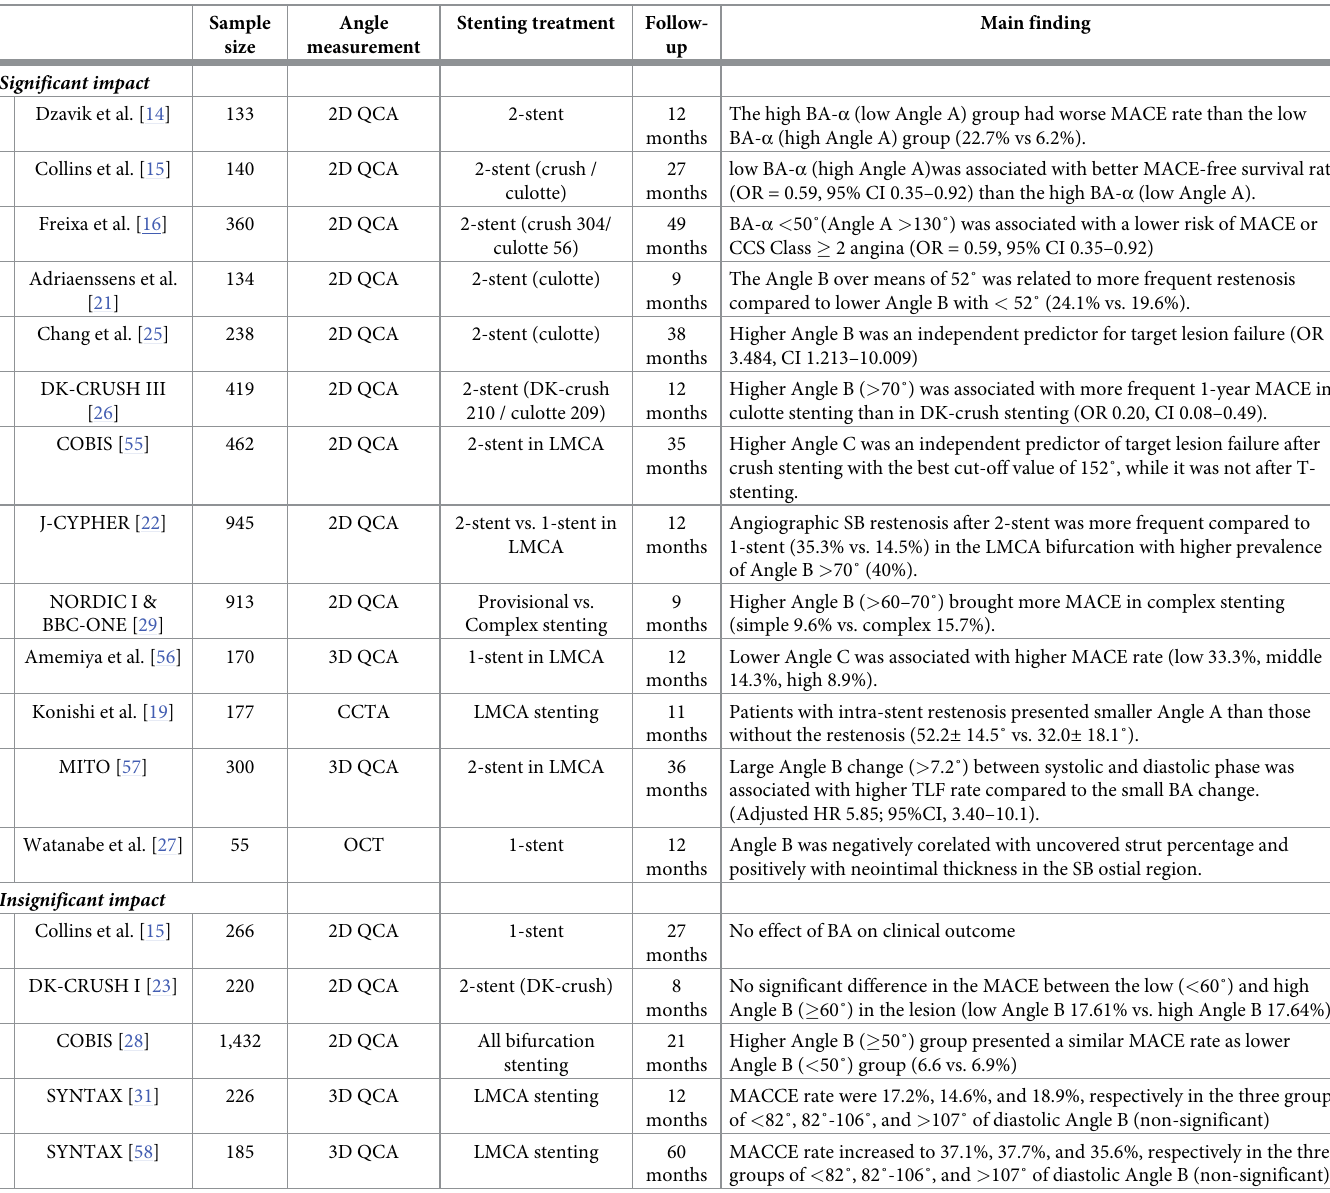
Table 2. Previous reports concerning impact of bifurcation angle on mid- to long-term clinical outcome after coronary bifurcation stenting.